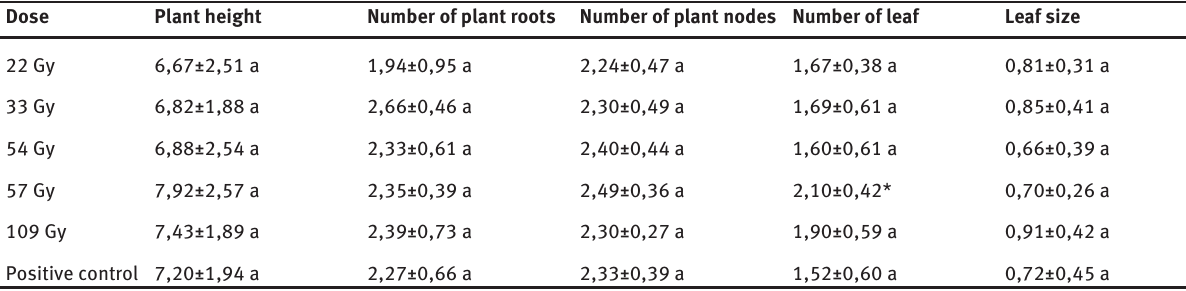
Table 3: Comparision of the plant parameters with the positive control groups. Dose Plant height